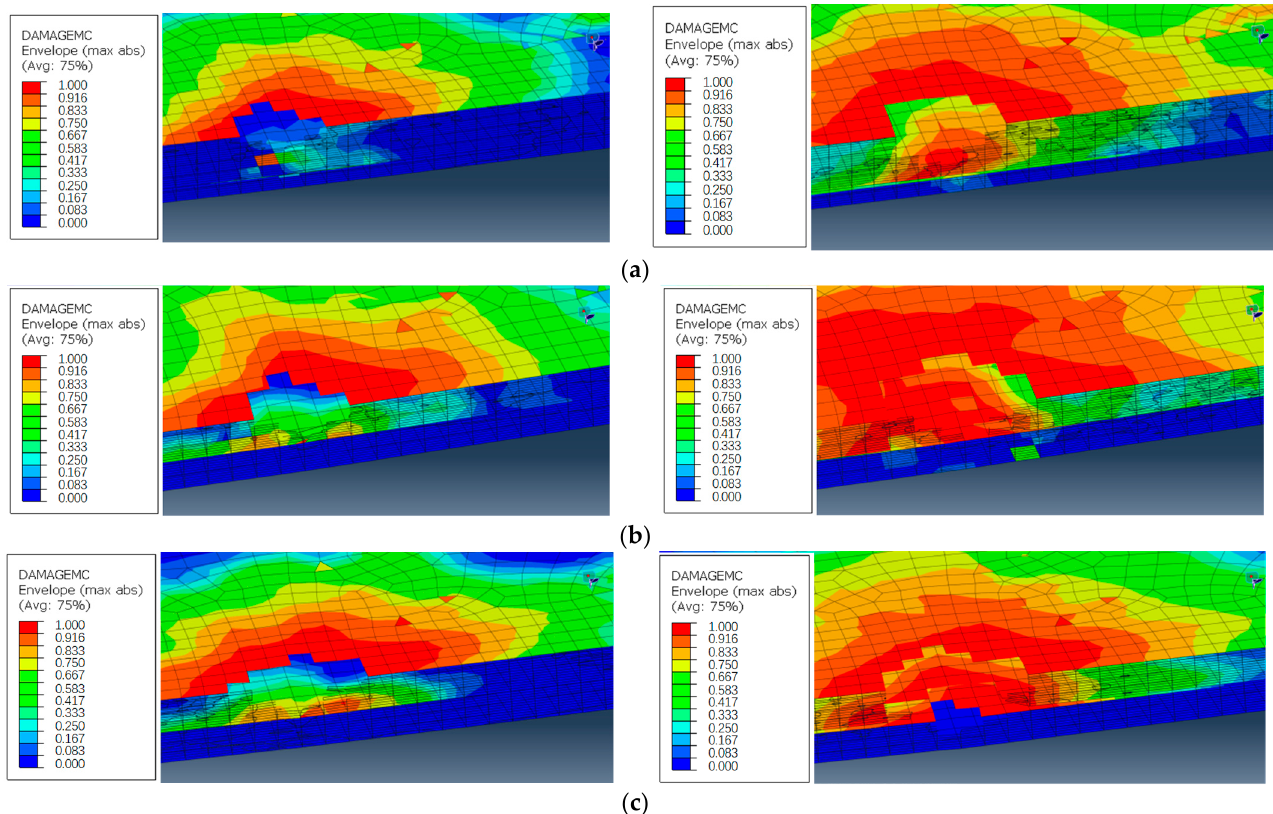
Figure 10. Hole wall mesh damage under different process parameters: ( a ) 5 − 10 mm/min, ( b ) 10 − 5 mm/min, ( c ) 5 mm/min. ( b ) 10 − 5 mm/min, ( c ) 5